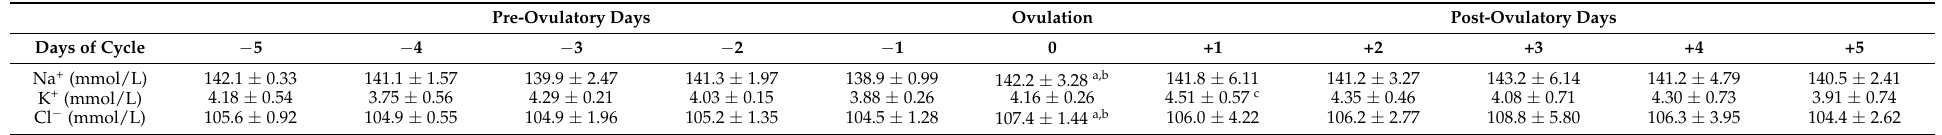
Table 1. Electrolyte concentrations (mean ± SD) in cycling mares (n = 23) from day − 5 pre-ovulation to day 5